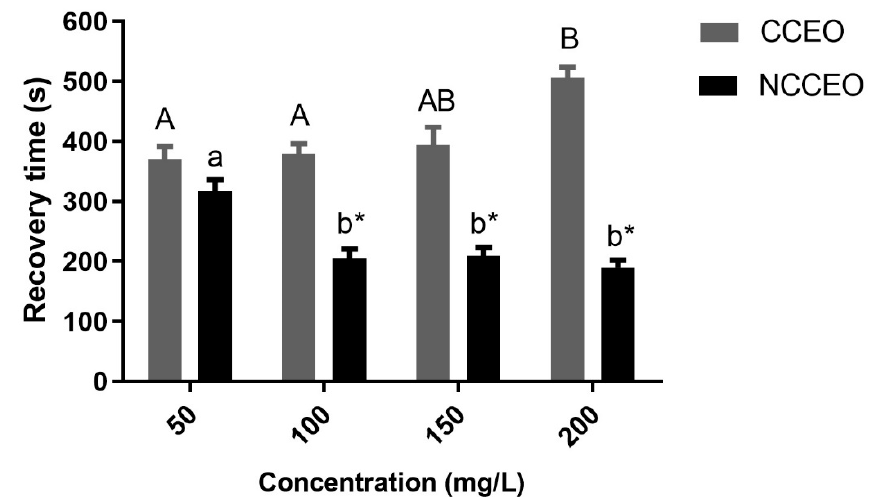
Figure 2. Anesthetic recovery time of Chinese cinnamon ( Cinnamomum cassia ) essential oil (CCEO) and its nanoemulsion (NCCEO) in silver catfish ( Rhamdia quelen ) by immersion bath. Values are expressed as the mean SEM ( n = 8). Uppercase letters indicate significant difference between CCEO ± concentrations; lowercase letters indicate significant difference between NCCEO concentrations; * asterisk indicates significant difference from CCEO at the same concentration (two-way ANOVA and Tukey’s test, p < 0.05).